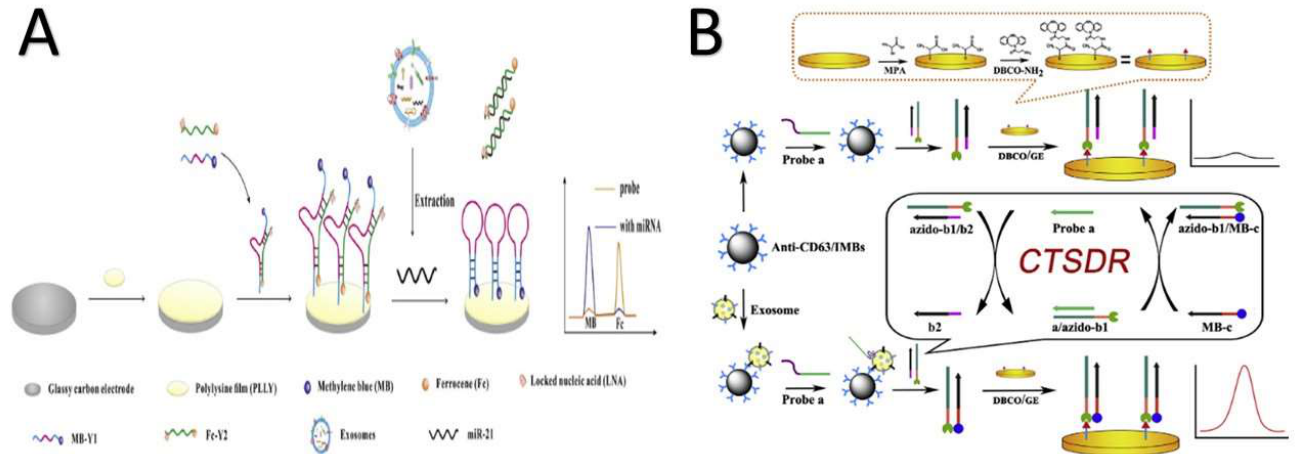
Figure 8. Examples of electrochemical platforms for exosome detection and quantification. The figure permissions are as